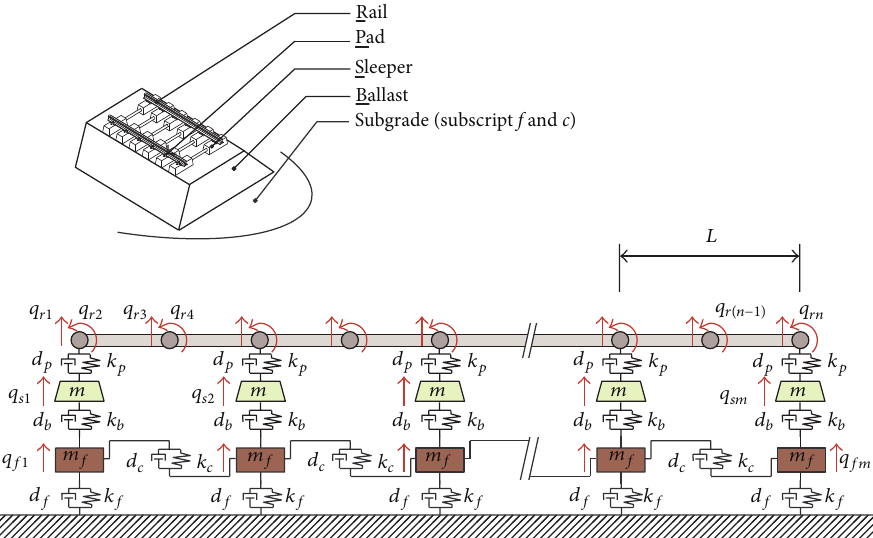
Figure 2: Dynamic model of the track, including the